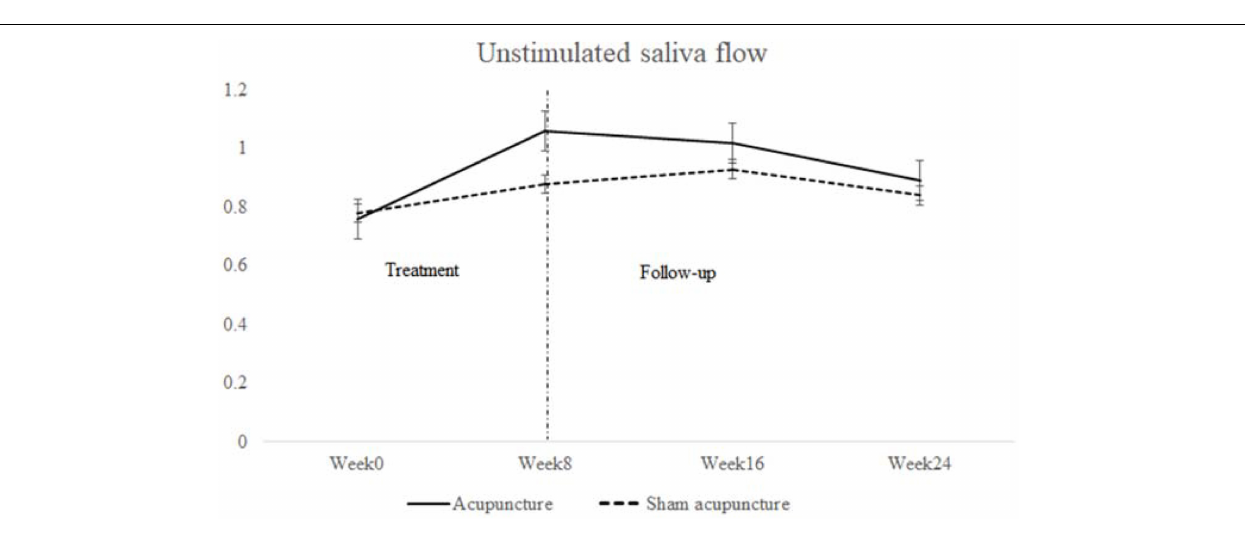
FIGURE 3 | Unstimulated saliva flow at weeks 0, 8, 16, and 24. of acupuncture were excluded from statistical analysis.